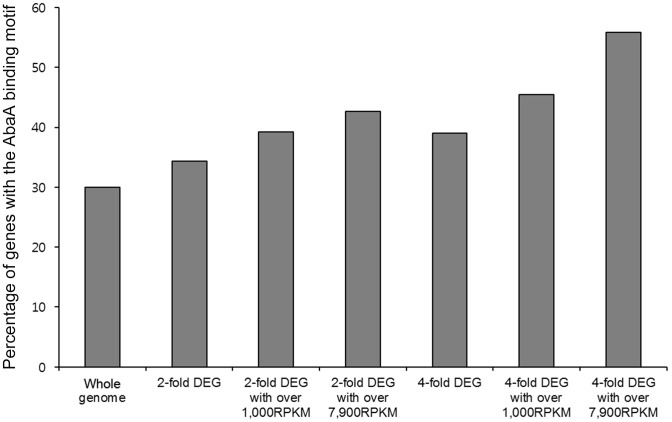
Percentage of DEGs among AbaA binding motif-containing genes.All information on F. graminearum sequences and annotation was obtained from the F. graminearum Database (http://mips.helmholtz-muenchen.de/genre/proj/FGDB/) [51]. From this genome sequence and gene annotation, 500-bp upstream sequences were collected from all predicted genes and surveyed for finding CATTCY motifs in these regions [60]. DEGs between F. graminearum wild-type strain Z-3639 and abaA deletion mutant were compared with genes having CATTCY motifs within 500-bp upstream sequences to calculate percentages of DEGs among CATTCY motifs -containing genes. DEG, differentially expressed genes; RPKM, reads per kilobase of exon per million.